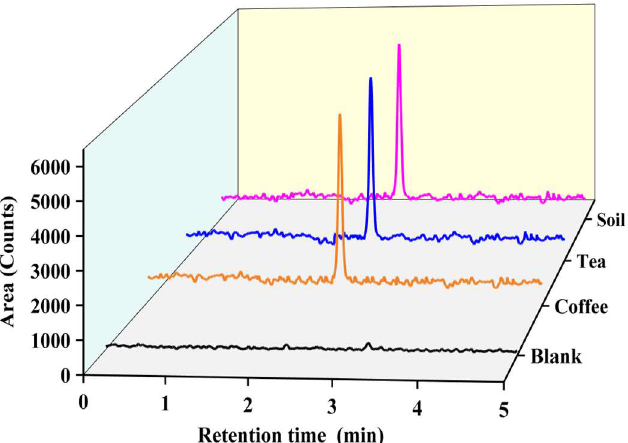
Figure 4. Total ion chromatogram of blank solvent, and 1 ng/g OTA extracted from coffee, tea, and soil matrix. Table 1. Real sample analysis (coffee, tea, and soil) by the proposed method (n = 3).